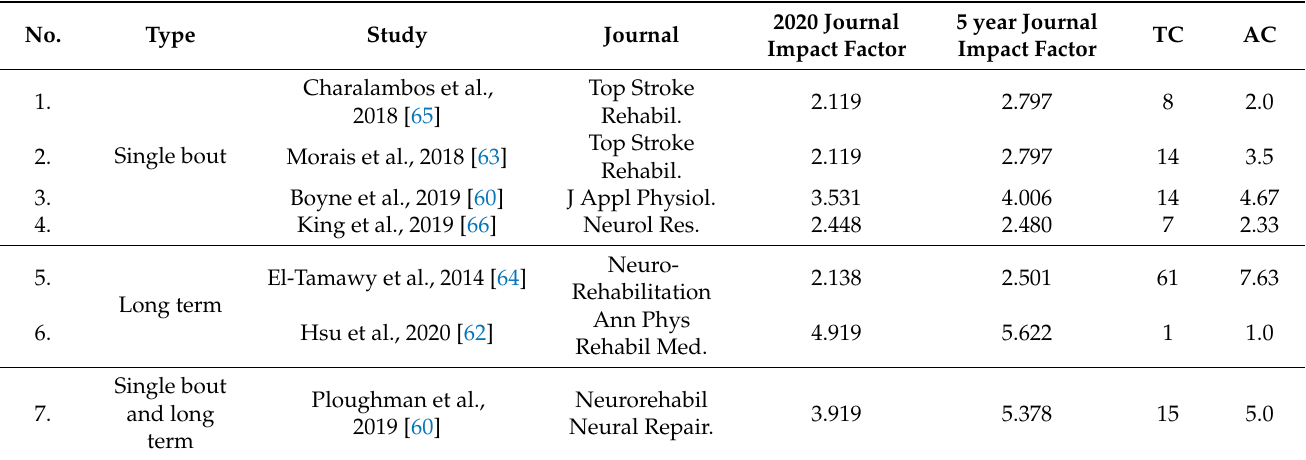
Table 2. Clinical trials on endurance exercise and post-stroke BDNF concentration and their quality evaluation based on the Web of Science Core Collection (Clarivate Analytics).